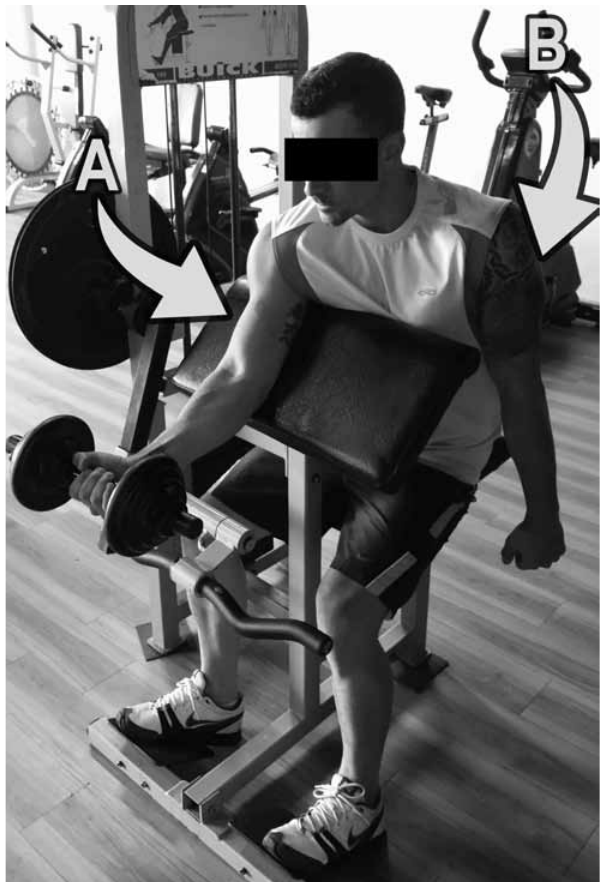
Figure 1. Experimental condition: (A) dynamic task of the right elbow flexor; (B) maximum isometric contraction of the left elbow